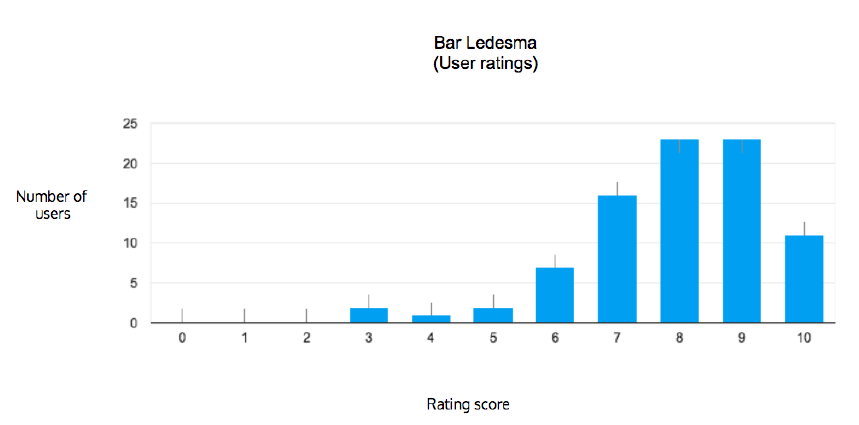
Figure 4. Ratings gathered from